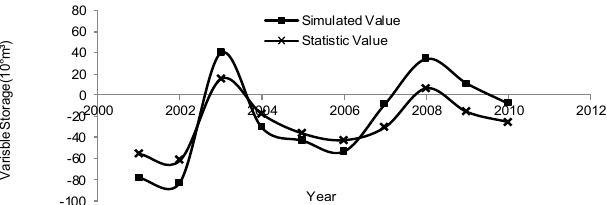
Fig. 2 The shallow groundwater storage curve of the Haihe River basin from 2001 to 2010.